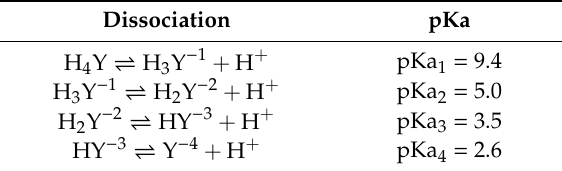
Table 1. The acid dissociation constants (pKa) for 0.1 M GLDA at 25 ◦ C [31].